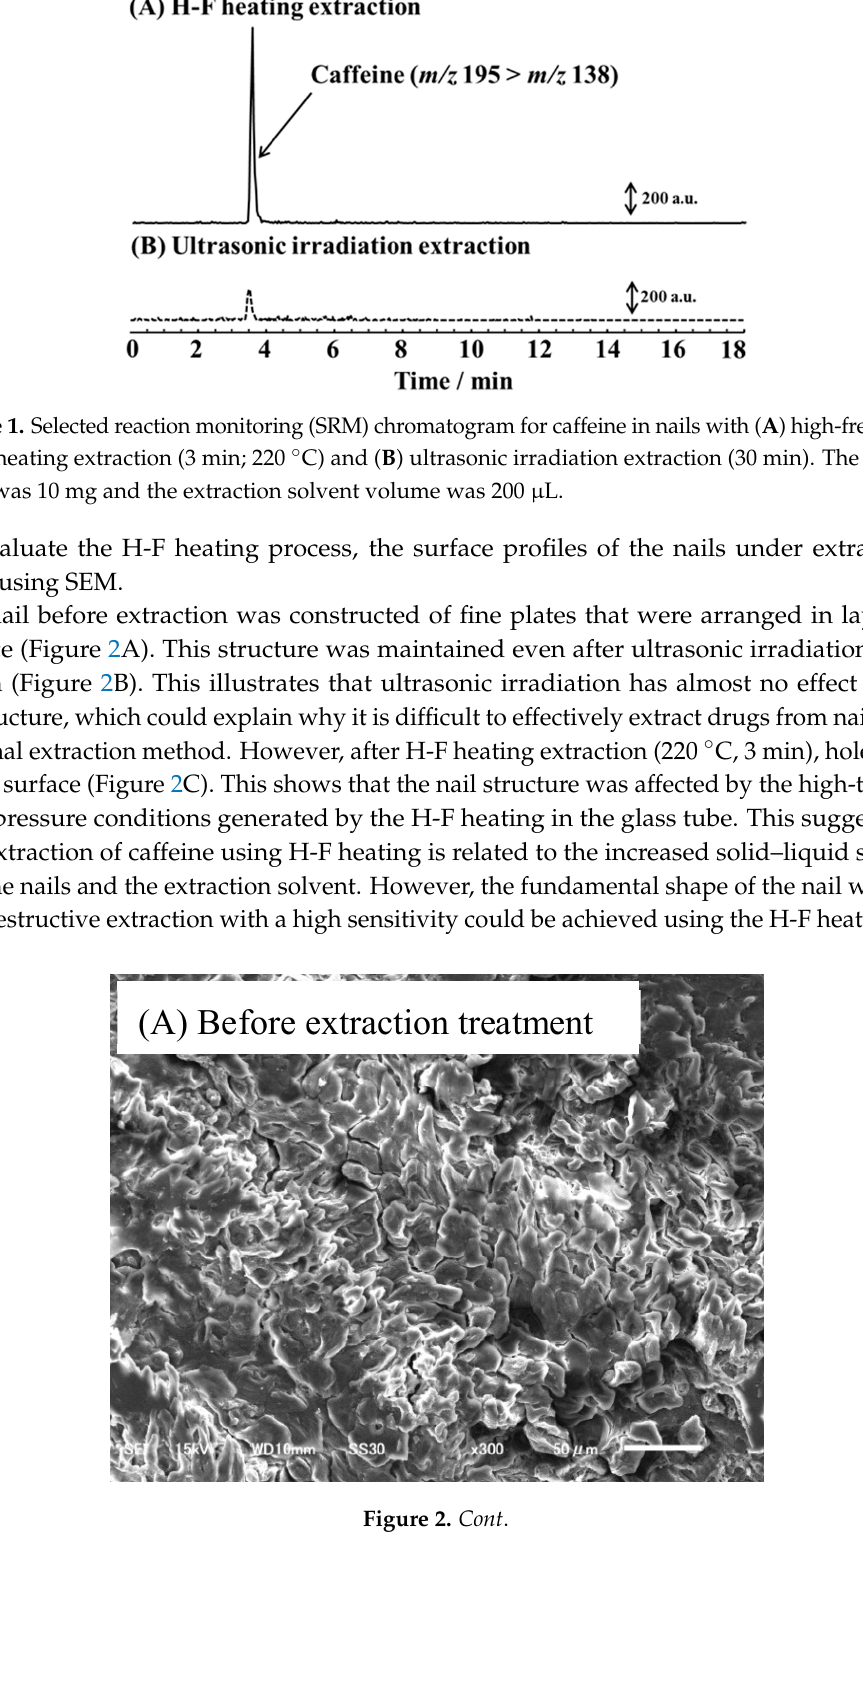
Figure 2. SEM images of the nail surface ( A ) before the extraction treatment, ( B ) after ultrasonic irradiation extraction (30 min), and ( C ) after H-F heating extraction (3 min). The nail before extraction was constructed of fine plates that were arranged in layers on the nail surface (Figure 2A). This structure was maintained even after ultrasonic irradiation extraction for 30 min (Figure 2B). This illustrates that ultrasonic irradiation has almost no effect on the nail surface structure, which could explain why it is difficult to effectively extract drugs from nails using the conventional extraction method. However, after H-F heating extraction (220 °C, 3 min), holes appeared on the nail surface (Figure 2C). This shows that the nail structure was affected by the high- temperature and high-pressure conditions generated by the H-F heating in the glass tube. This suggests that the effective extraction of caffeine using H-F heating is related to the increased solid– liquid surface area between the nails and the extraction solvent. However, the fundamental shape of the nail was retained, and non-destructive extraction with a high sensitivity could be achieved using the H-F heating method.